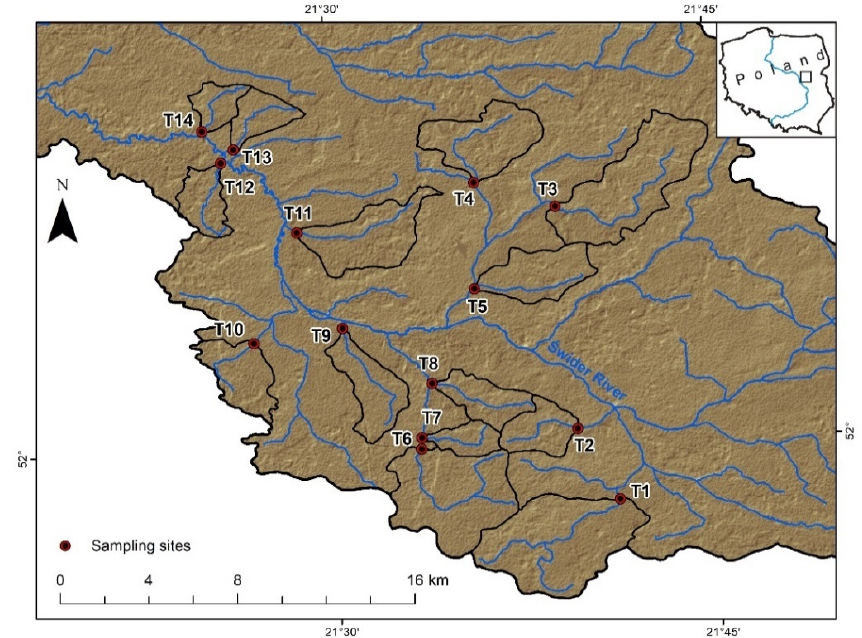
Figure 1. Location of the sampling sites in the ´Swider River catchment. The hillshade model was created on the basis of digital terrain model SRTM 1 Arc-Second Global (USGS).